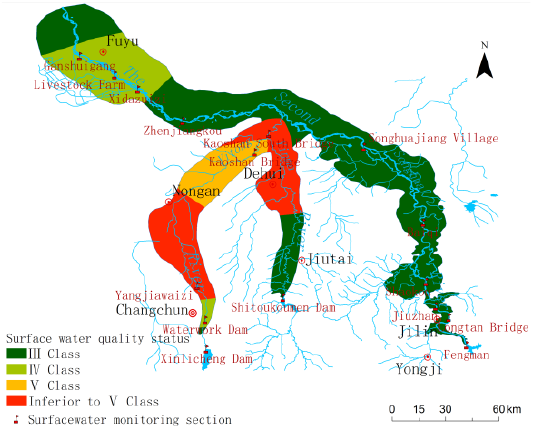
Water 2016 , 8 , 176